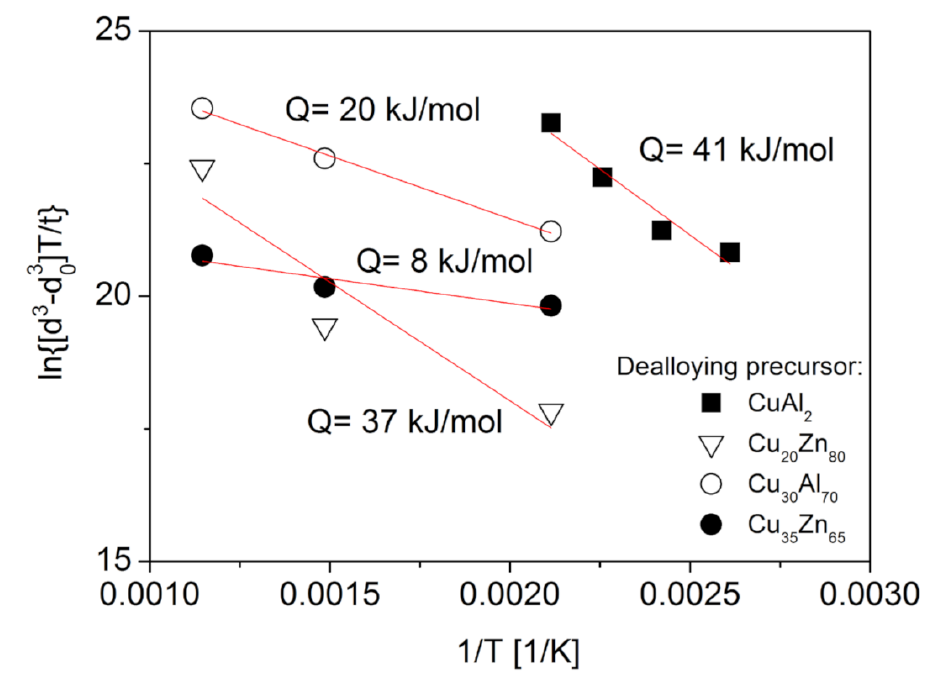
(cid:8)(cid:2) (cid:3) (cid:9) d 3 − d 3 T / t Figure 11. Plot of ln versus 1/ T to estimate the activation energy of the causal 0 mechanism of ligament coarsening for dealloyed Cu foams annealed under an oxidizing atmosphere. Solid squares indicate materials processed by route A from CuAl 2 , open down triangles reflect materials dealloyed from Cu 20 Zn 80 by using 5 wt.% HCl at RT for 72 h, solid circles indicate materials dealloyed from Cu 30 Al 70 by using 85 wt.% H 3 PO 4 at RT for 72 h, and open circles reflect materials dealloyed from Cu 35 Zn 65 by using 5 wt.% HCl at RT for 72 h. The data for the latter three types of precursor alloy were taken from Reference